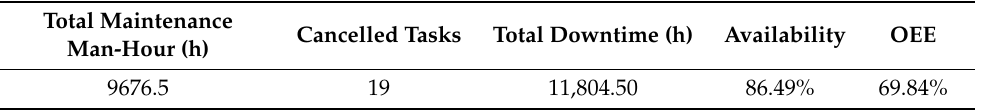
Table 2. Scenario 1